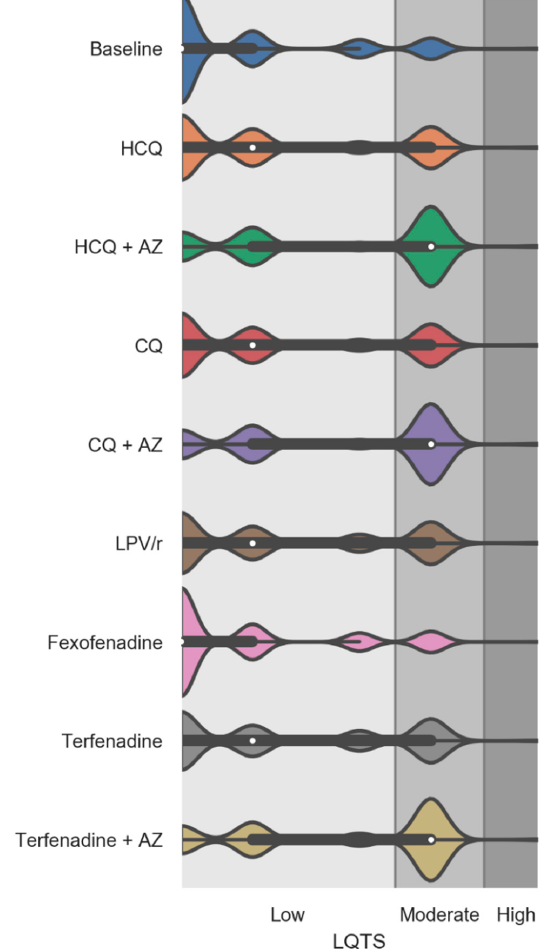
Figure 4. Violin plots showing the drug-induced Long QT Syndrome (LQTS) risk score factor at baseline and after the virtual addition of repurposed drugs into PACE participants’ drug regimens. Fexofenadine was used as a negative control and terfenadine alone and combined with AZ were used as positive controls on drug-induced LQTS score. The white dots are the medians, and the colored areas are probability density estimates. p < 0.0001 compared to the baseline for all repurposed drugs and terfenadine (alone and combined with AZ). Abbreviations: HCQ, hydroxychloroquine; AZ, azithromycin; CQ, chloroquine; and LPV/r, lopinavir + ritonavir.